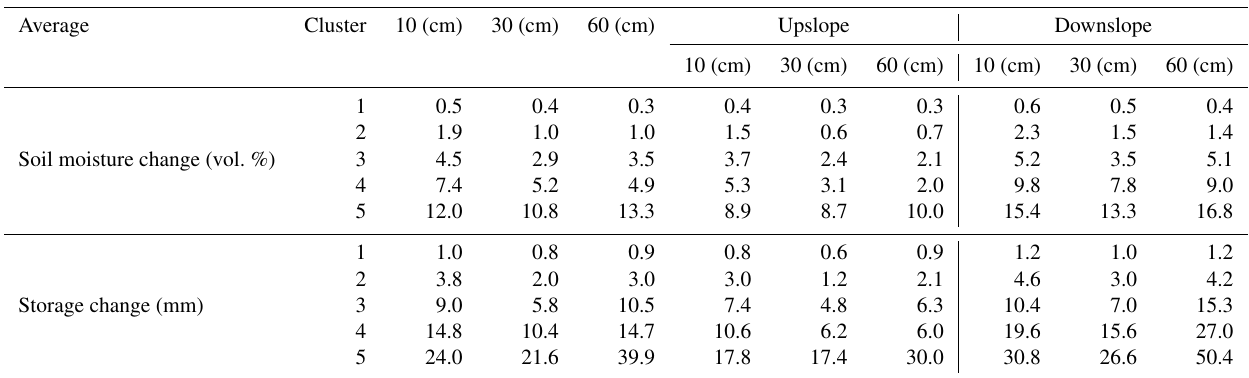
Figure 7. SDP2Ps with mean AMO and ASM for each cluster (a) soil moisture difference indices with mean DUR and INT for each cluster (b) for total, upslope, and downslope at depths of 10, 30, and 60cm, and the corresponding depths for upslope and downslope. Table 2. Soil moisture changes and storage changes for all clusters at depths of 10, 30, and 60cm and those recorded for upslope and